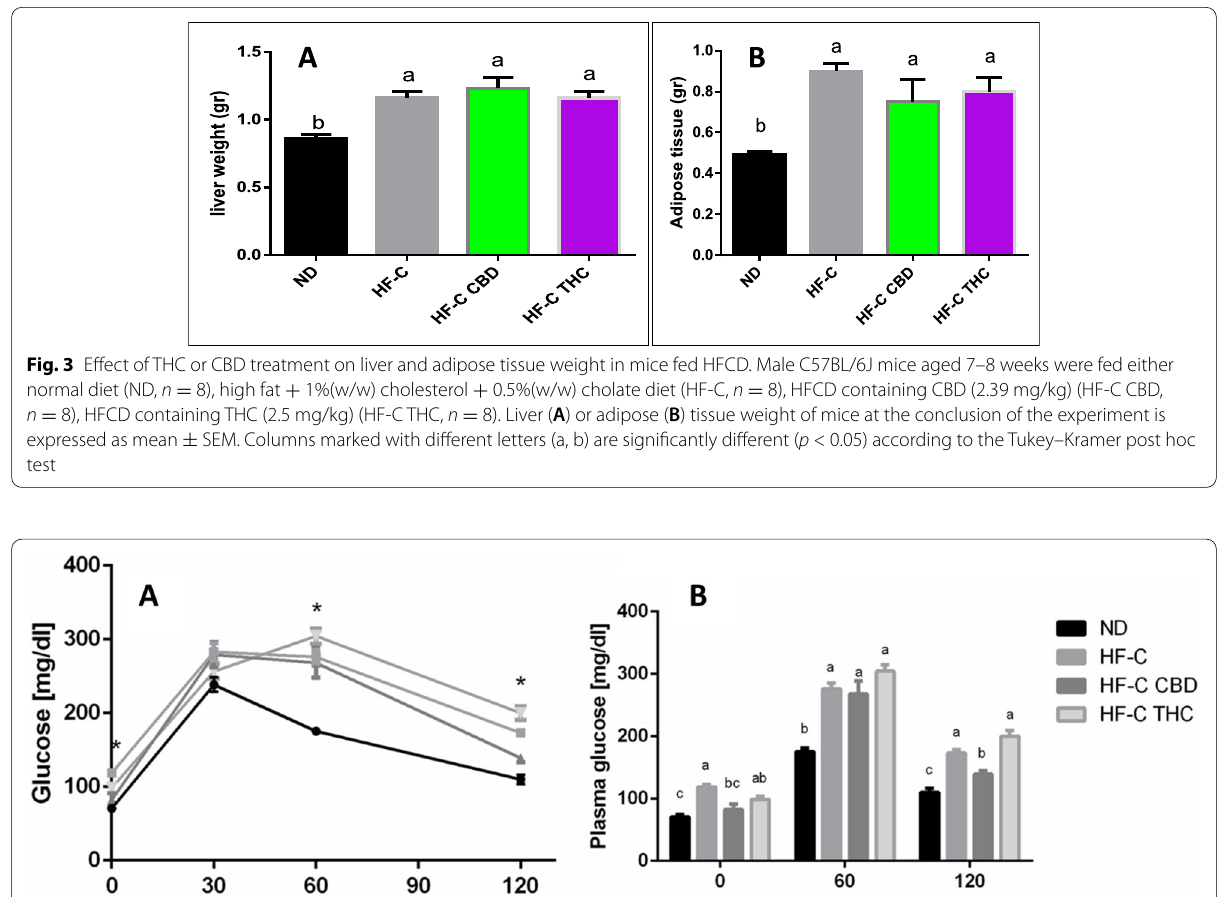
8), HFCD containing CBD (2.39 mg/kg) (HF‑C CBD, n =